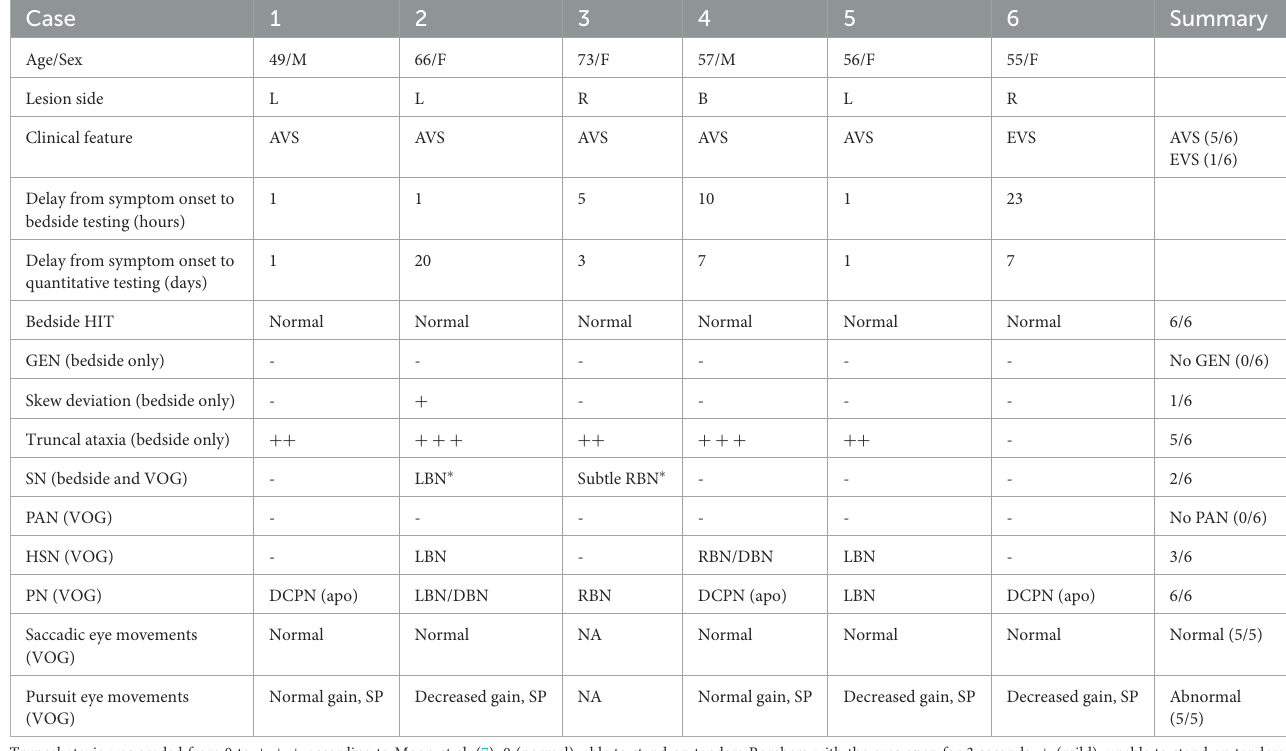
TABLE 1 Clinical and neuro-otologic and neuro-ophthalmologic findings.